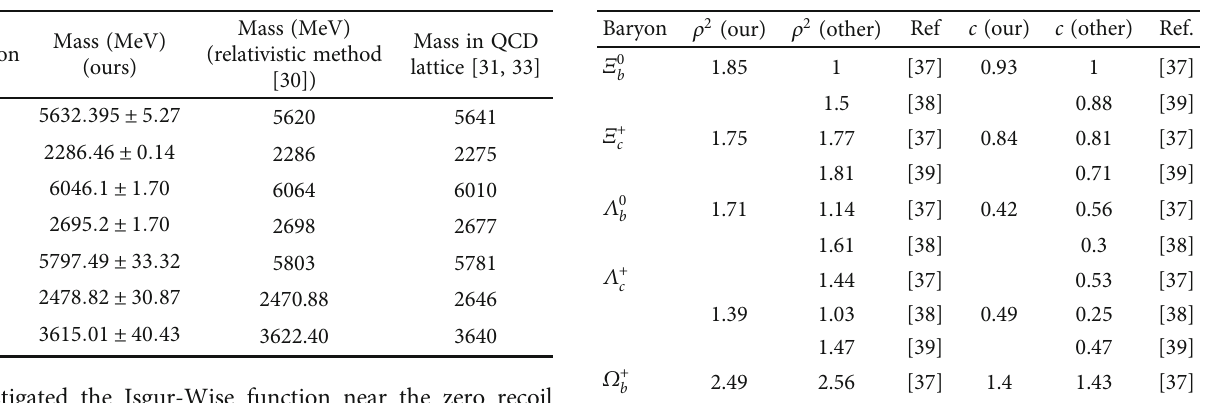
Table 4: Calculated masses of some heavy baryons. Table 5: Slope and curvature of IWF for some baryons.